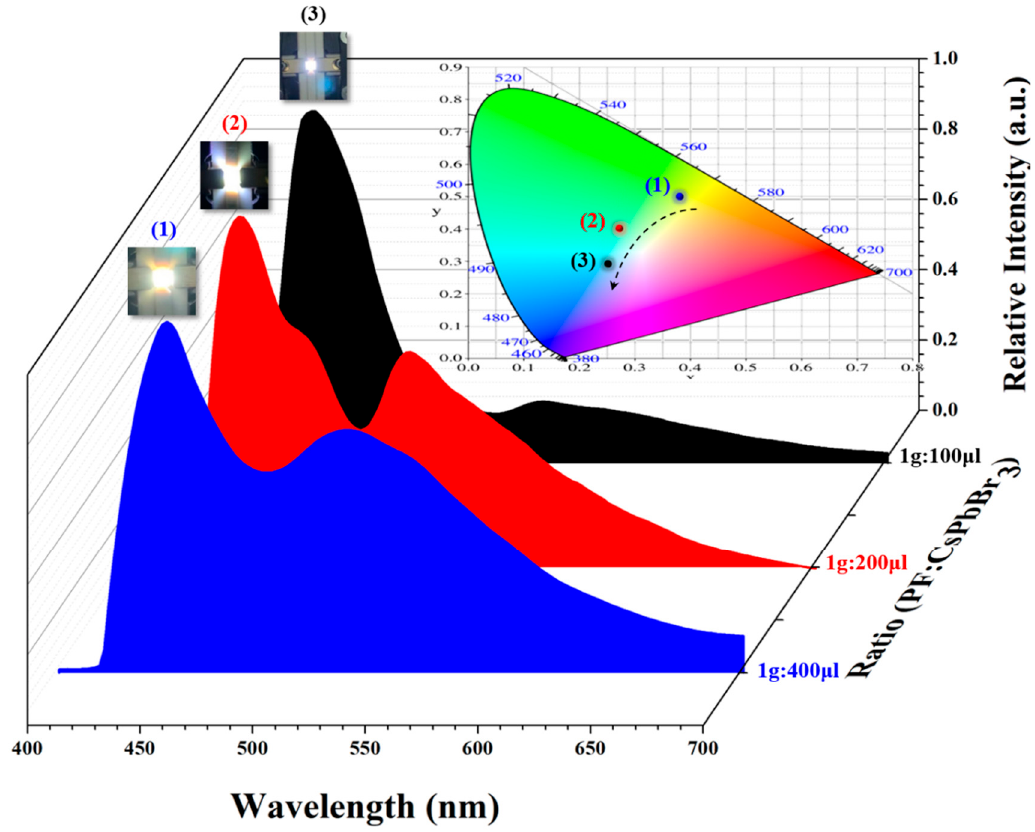
Figure 4. Emission spectra of di ff erent color light down-converter with CIE color coordinates obtained using CsPbBr 3 @ PF 8k - b -PBA 12k composite fibers under UV chip (380 nm) excitation and an applied voltage of 3 V. (Inset images show the light down-converter with an applied QD / polymer composite fiber ratio of 100:1, 200:1, and 400:1 ( μ L/g)).